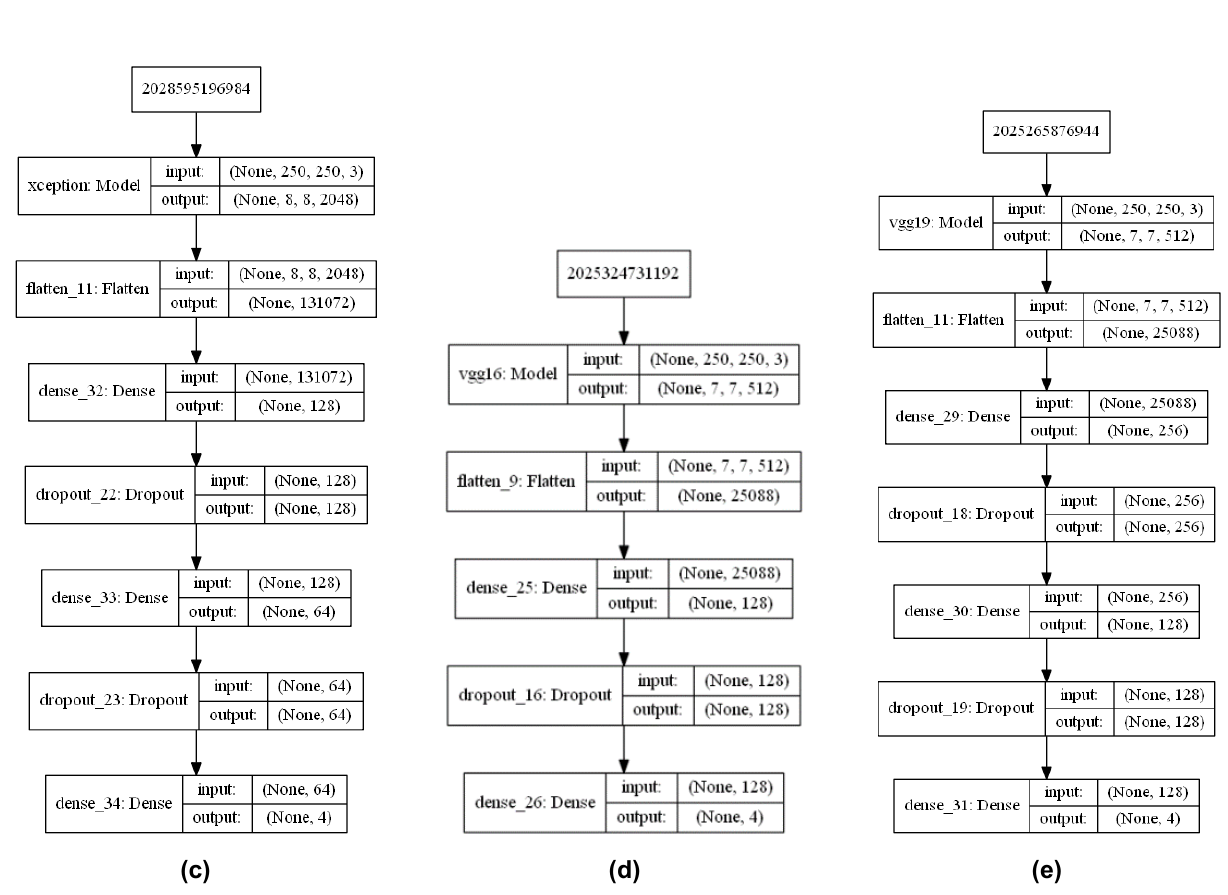
Figure 6(c) The Architecture of model (5) of AiCNNs (i.e. Artificially integrated Convolution Neural Networks) from Table 2. This is a transfer-learned Xception model . (d) The Architecture of model (7) of AiCNNs (i.e. Artificially integrated Convolution Neural Networks) from Table 2. This is a transfer-learned VGG16 model . (e) The Architecture of model (8) of AiCNNs (i.e. Artificially integrated Convolution Neural Networks) from Table 2. This is a transfer-learned VGG19 model . None of these models use data augmentation as it tends to increase the overfitting which will be discussed later.